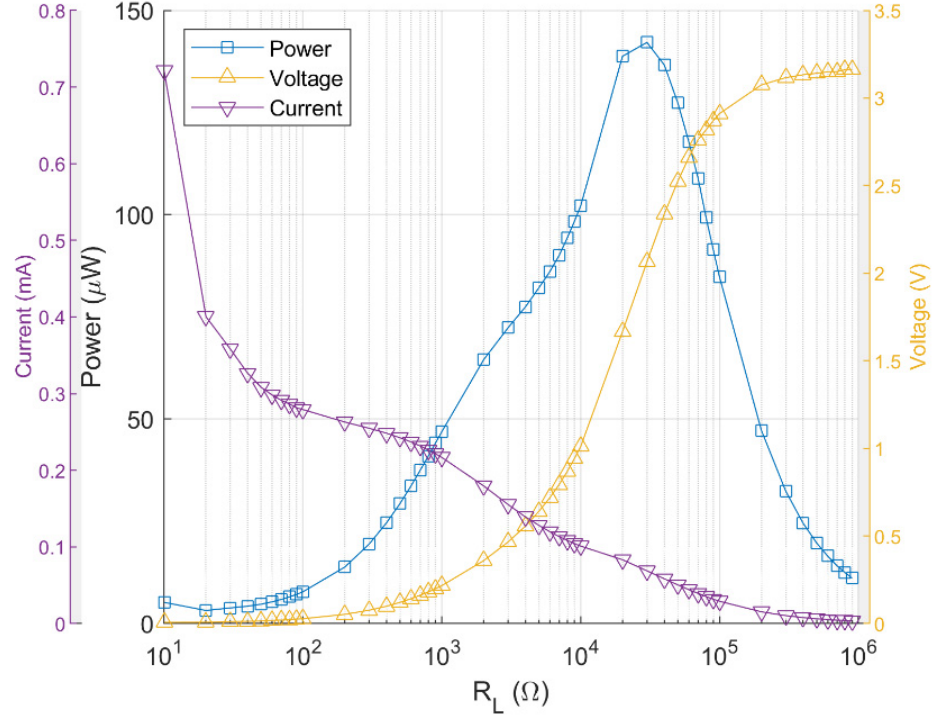
Figure 11. Power, voltage, and current depend on the load resistance value R L for PEH excited by a sinusoidal wave with an amplitude of 5 V and frequency of 25.4 Hz.